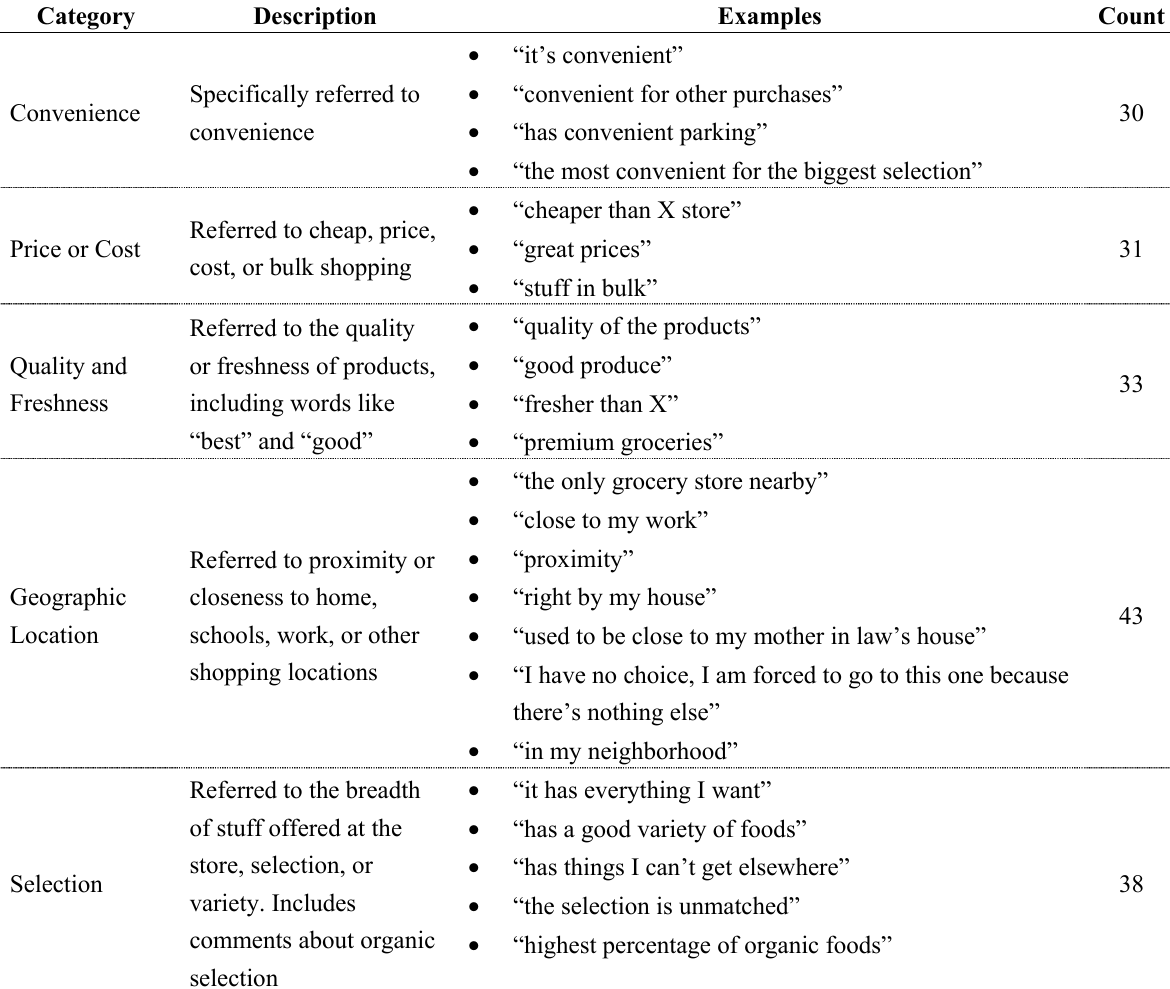
Table 3. Qualitative justifications for choosing stores, grouped into seven broad categories.